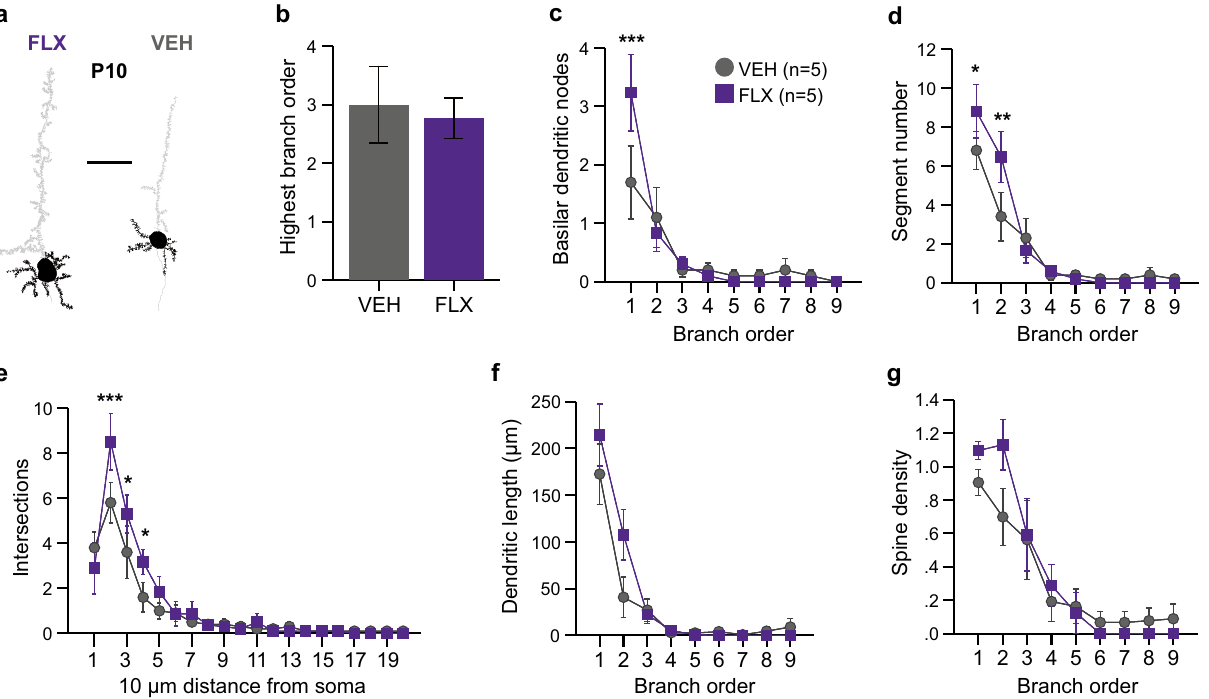
Figure 4. Dendritic features of mPFC layer V pyramidal neurons are increased at P10 by Maternal FLX. ( a ) Representative tracings of Golgi-Cox impregnated mPFC layer V neurons from P10 FLX and VEH brains. Areas in black indicate quantified basilar dendrites and soma. Scale bar is 50 µm. ( b ) Comparable branching orders were achieved by FLX- and VEH-exposed mPFC layer V neurons at P10 (n = 10 neurons averaged from 5 VEH mice and n = 10 neurons averaged from 5 FLX mice). ( c ) First order branching nodes were increased in FLX- exposed brains. ( d ) The number of basilar dendritic segments per branch order were increased in FLX-exposed neurons at the 1st and 2nd orders. ( e ) FLX-exposed neurons showed an increased in intersections 20–40 µm distance from the soma as assessed by Sholl analysis. ( f-g ) No difference was observed for basilar dendritic length or spine density between P10 FLX- and VEH-exposed neurons. Data are means ± SEM. Statistical significance, ***p < .001, **p < .01, *p <